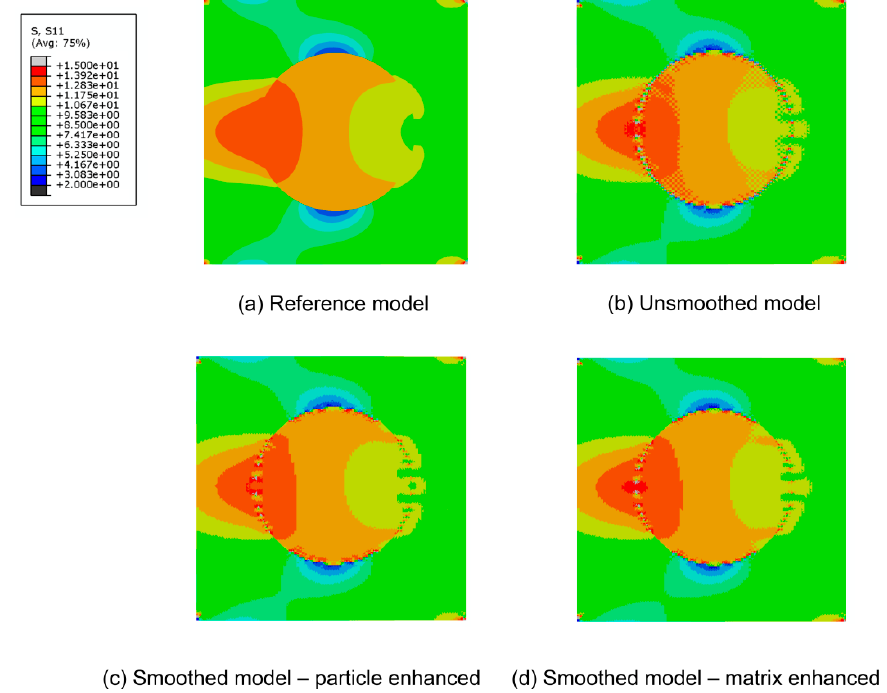
Figure 8. x -directional stress distributions: ( a ) reference model; ( b ) unsmoothed model; ( c ) smoothed model-particle enhanced; ( d ) smoothed model-matrix enhanced.